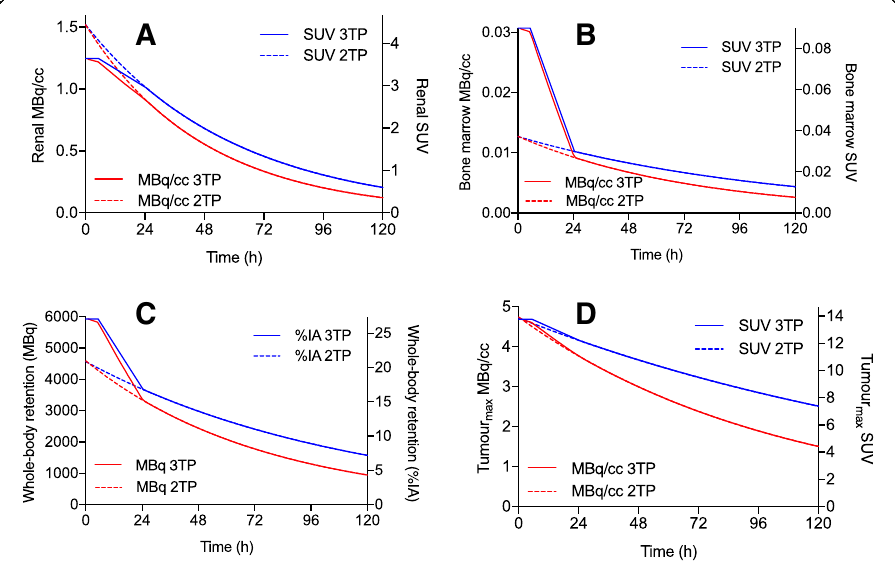
Fig. 2 Time-activity curves (TACs) of the renal ( a ), tumor ( b ), and bone marrow ( c ) activity concentrations and of the whole-body retention ( d ) over time for the patient case illustrated in Fig. 1. TACs in MBq/cc or MBq (red) and SUV or percentage of injected activity (%IA) (blue) are illustrated for the three-time-point (3TP; solid lines) and two-time-point (2TP; dashed lines)